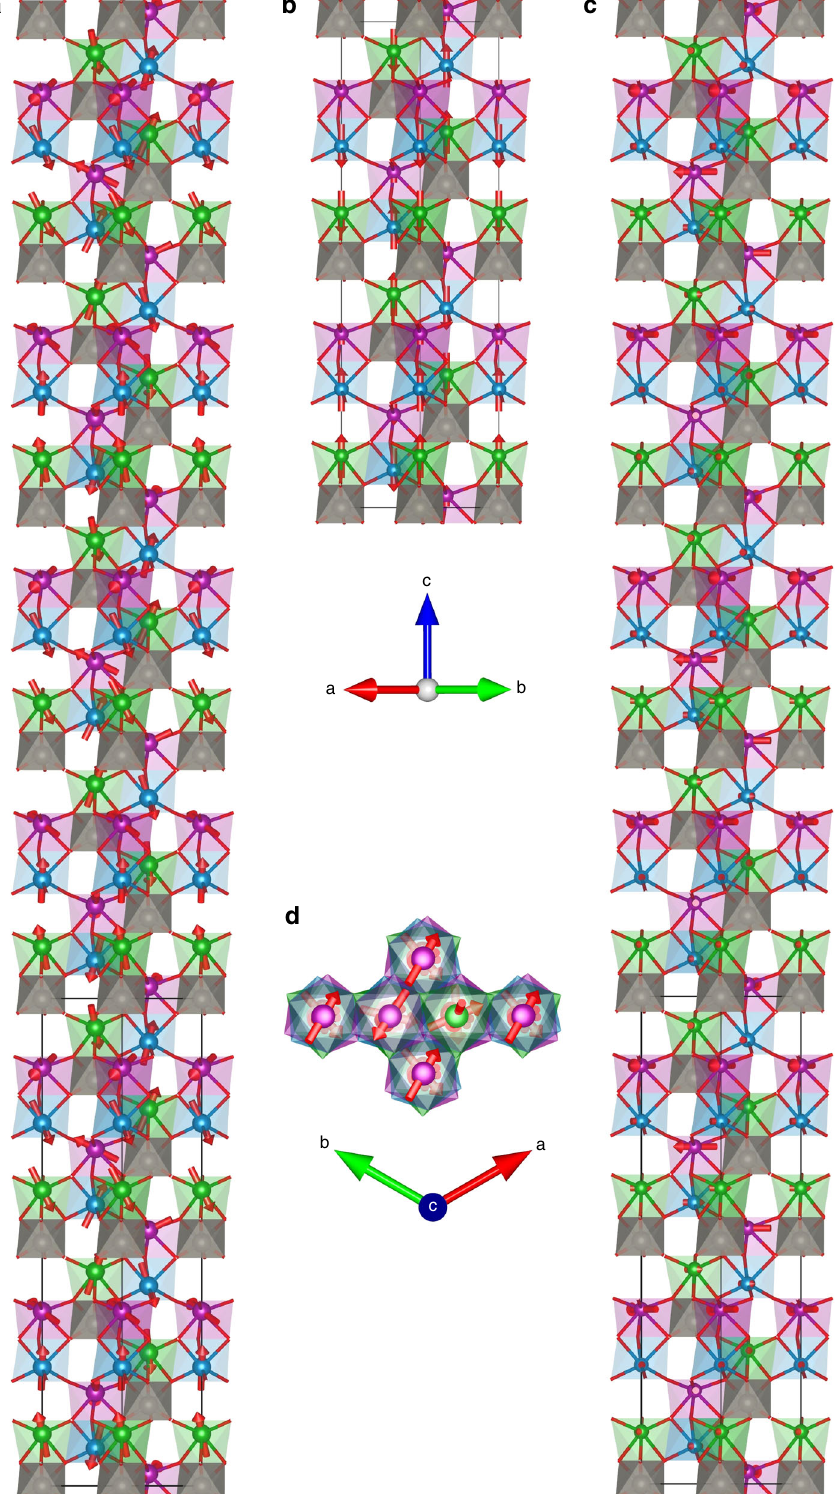
Fig. 3 Illustration of the nuclear and magnetic structures of Mn 2 MnWO 6 at 5 K. Mn1, Mn2, Mn3 and W sites and polyhedra are shown in green, purple, blue and grey, respectively, with Mn moments shown by red arrows (color online) (oxide ions are omitted for clarity). a shows the complete magnetic structure (showing six times the nuclear unit cell along c ). b shows only the z component of Mn moments (described by commensurate mT1 irrep) and c shows only the xy component of Mn1 and Mn3 moments (described by m Λ 2LE2 irrep) (showing six times the nuclear unit cell along c ), also d showing view down along c axis of magnetic unit